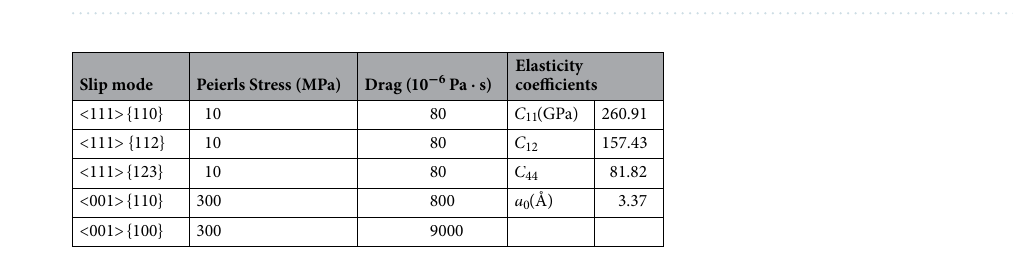
Table 3. The material parameters used in the DDD simulations of